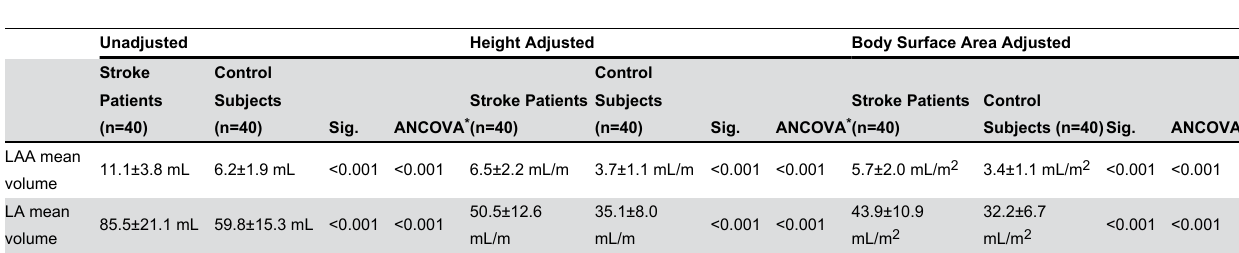
Table 2. Left Atrial Appendage (LAA) and Left Atrium (LA) Volume Measurements, Pair-wise Comparison between Patients with Cryptogenic Stroke (n=40) and Age- and Gender-Matched Control Subjects